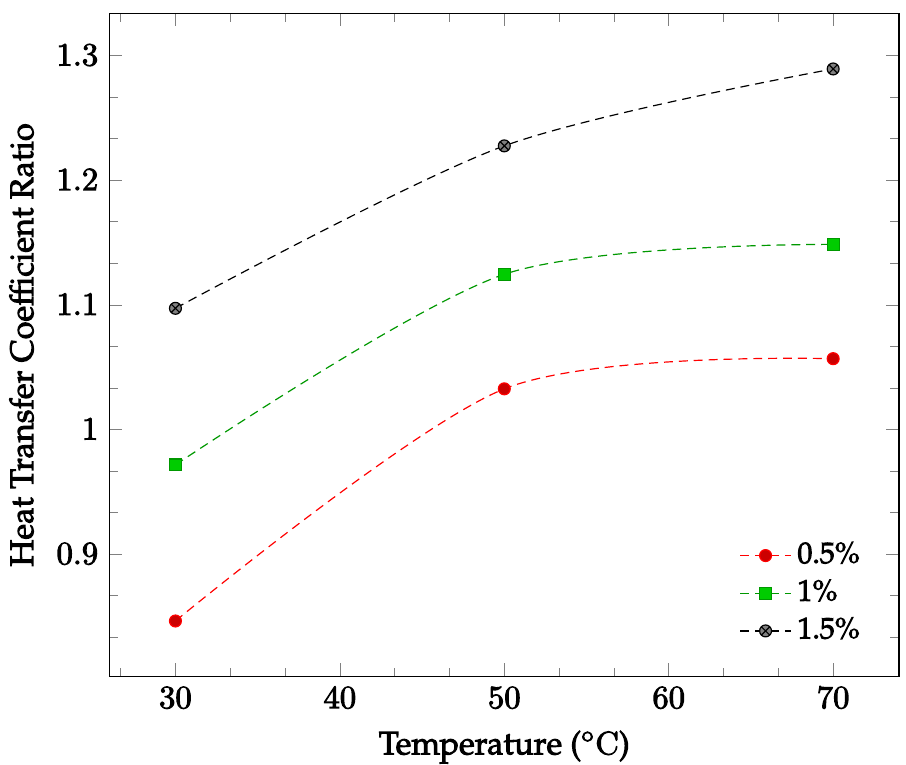
Figure 7. Nanofluid heat transfer coefficient as a function of temperature for volume fractions between 0.5–1.5% of TiO 2 nanoparticles in 60%:40% EG-water [49].